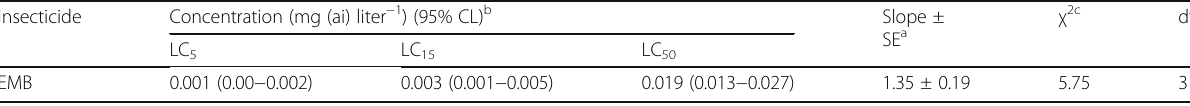
Table 1 Toxicity of emamectin benzoate to the first larvae of Spodoptera littoralis Insecticide